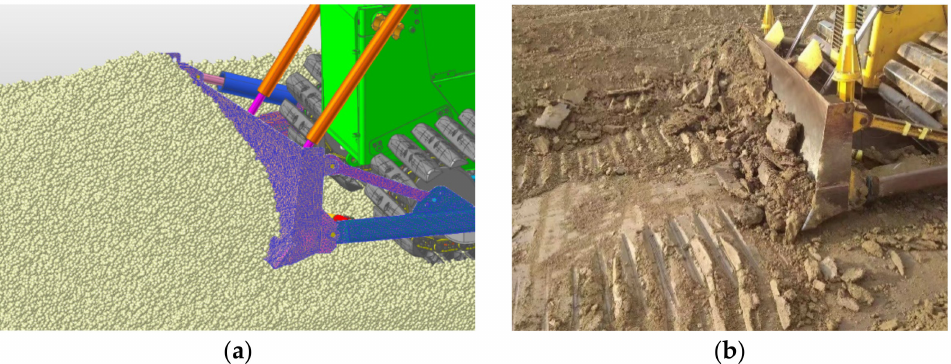
Figure 14. Comparison of the soil views in front of the blade: ( a ) in the simulation; ( b ) in the